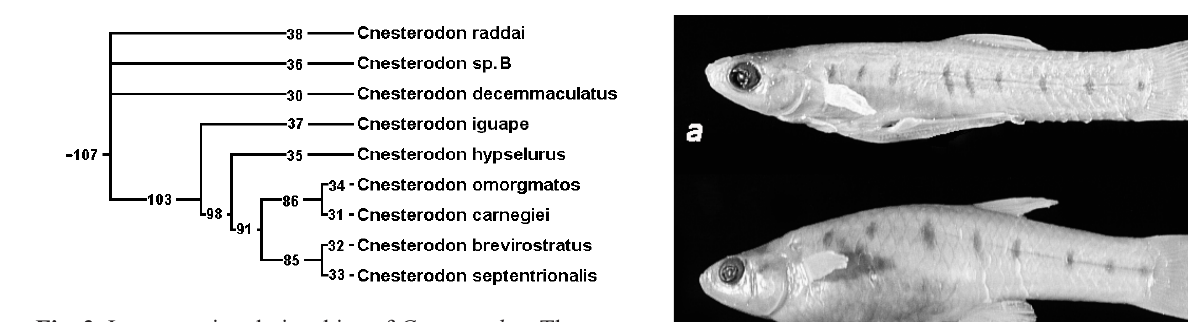
Fig. 2. Intrageneric relationships of Cnesterodon . The num- bers on the branches refer to the character state transforma- tions series by Lucinda & Reis (2005). SL.spective proximal radials in adult males [77-1]; (12) lateral pro- cess on base of fifth median anal-fin radial very large in